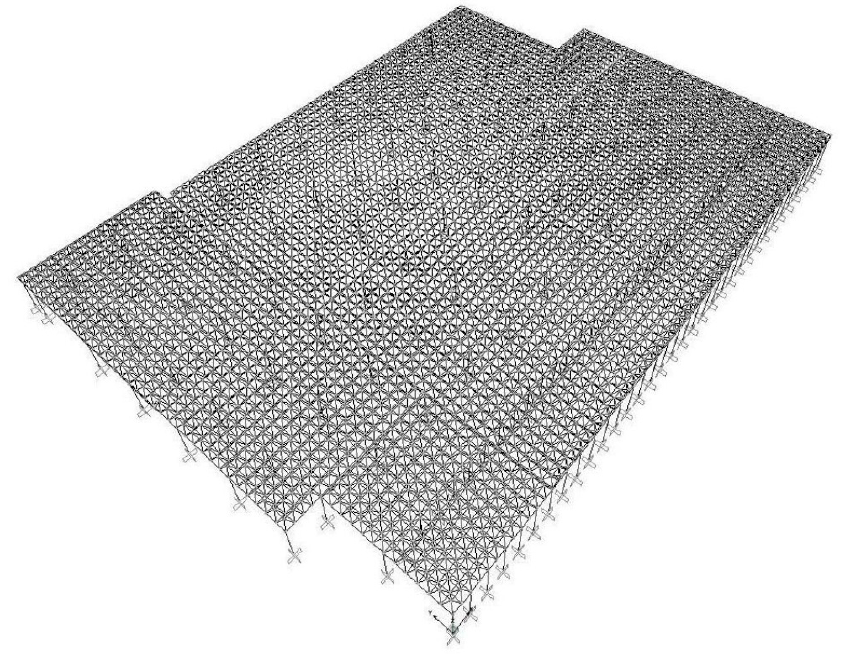
Figure 6. Three-dimensional finite element model prepared for finite element (FE) analysis.